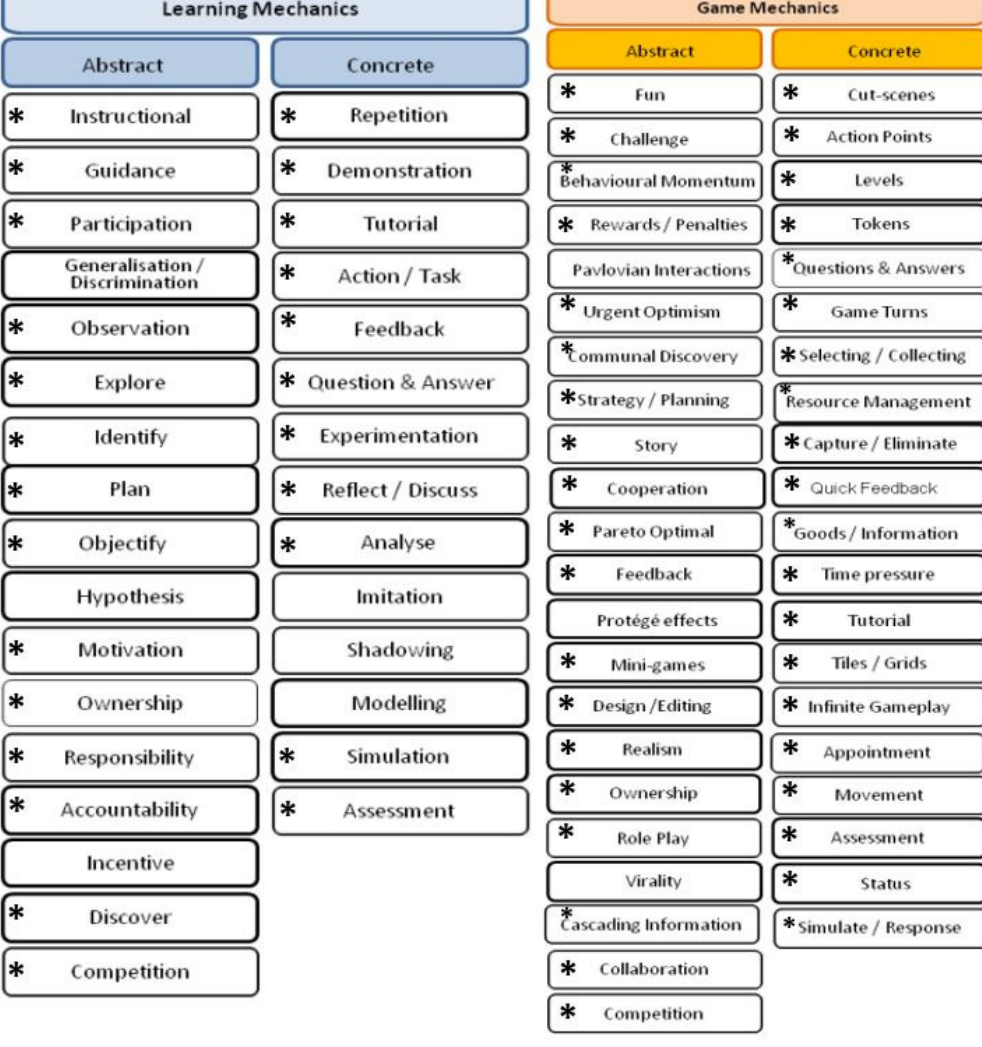
Figure 5. ViLLE LMS design influence determinants (* sign) in the LM-GM model.